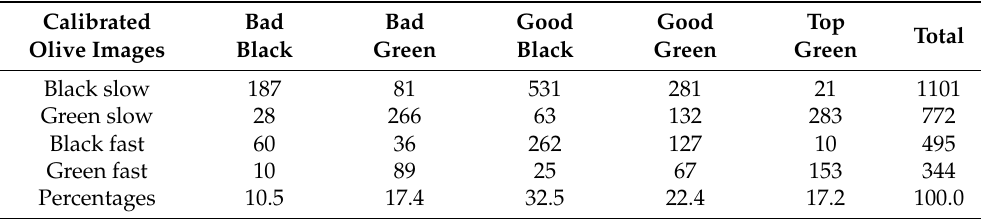
Table 5. Results of the external test of calibrated olives images. The rows report the sorting machine output, while the columns report the conveyor belt results.